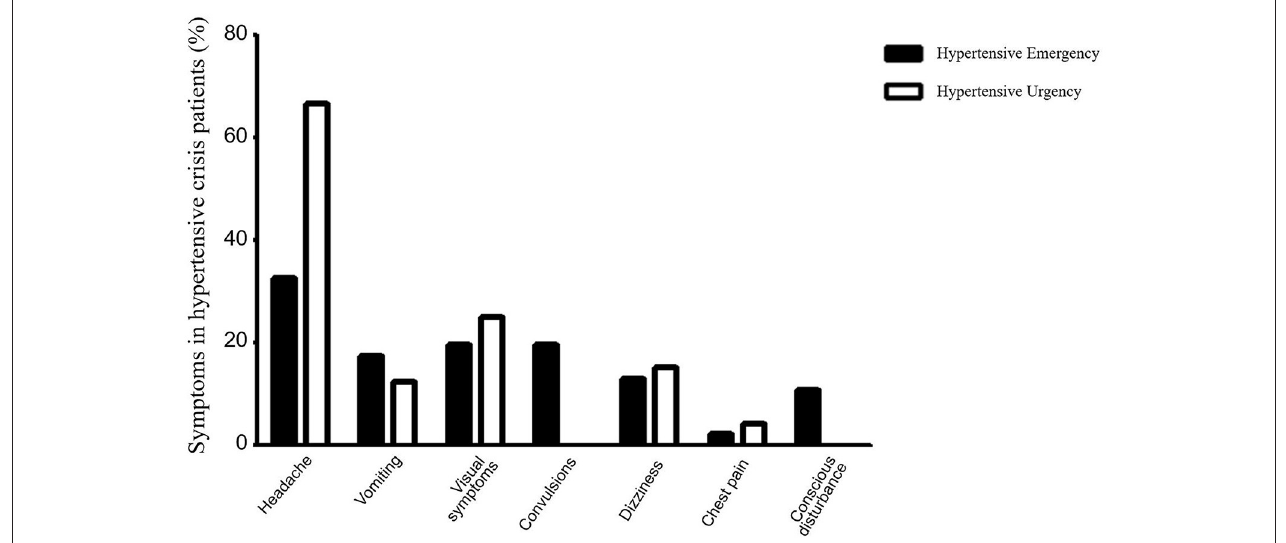
FIGURE 3 | Comparison of clinical symptoms between the hypertensive emergency group and the hypertensive urgency group. The solid columns represent the hypertensive emergency group and the hollow columns represent the hypertensive urgency group. In the hypertensive emergency group, headache was present in 15 cases (32.61%), vomiting in 8 cases (17.39%), vision symptoms in 9 cases (19.57%), convulsions in 9 cases (19.57%), dizziness in 6 cases (13.04%), chest pain in 1 case (2.17%), and conscious disturbance in 5 cases (10.87%). In the hypertensive urgency group, headache was present in 16 cases (66.67%), vomiting in 3 cases (12.50%), visual symptoms in 6 cases (25.00%), dizziness in 7 cases (29.17%), and chest pain in 1 case (4.17%), with no cases of convulsion or disturbance of consciousness. Further analysis showed that the incidence of convulsions was significantly higher in patients with hypertensive emergency than those with hypertensive urgency ( χ 2 = 5.38, p = 0.02). The incidence of headache was significantly higher in patients with hypertensive urgency than those with hypertensive emergency ( χ 2 = 7.41, p = 0.006).